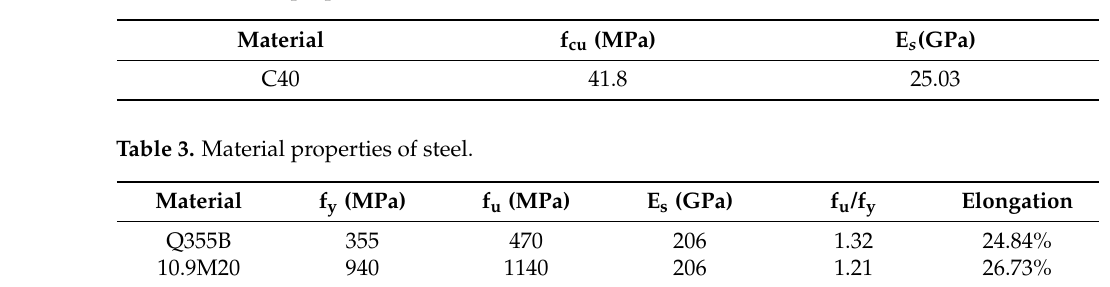
Table 2. Material properties of C40.